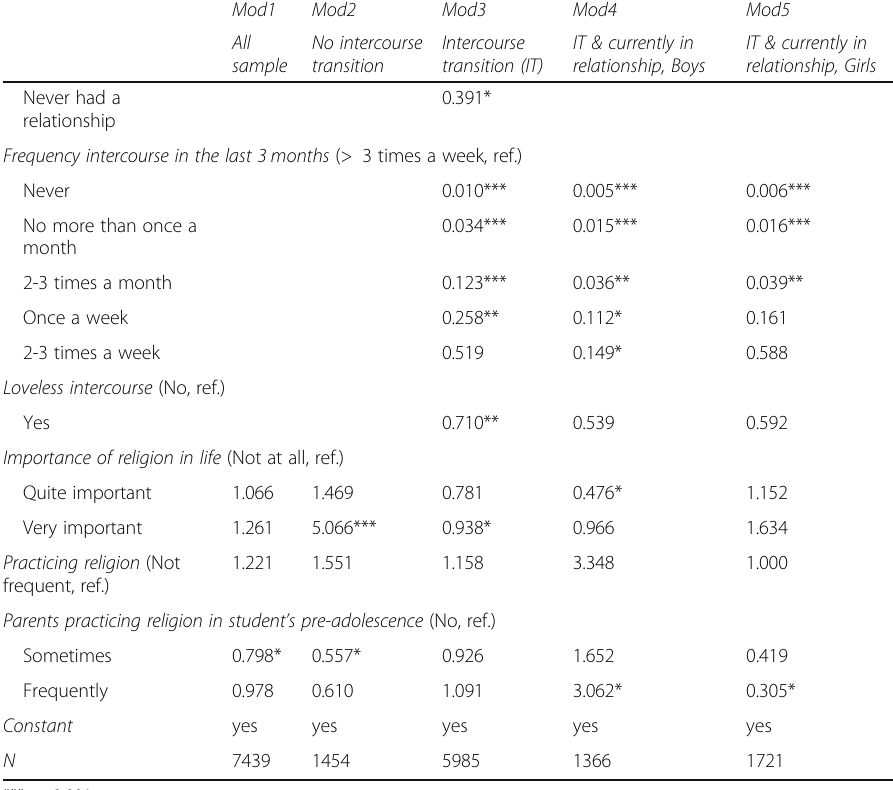
Table 3 Odds ratio of the logistic regression models with dependent variable sexual satisfaction (reference category ‘ Other ’ ) (Continued) Mod1 Mod2 Mod3 Mod4